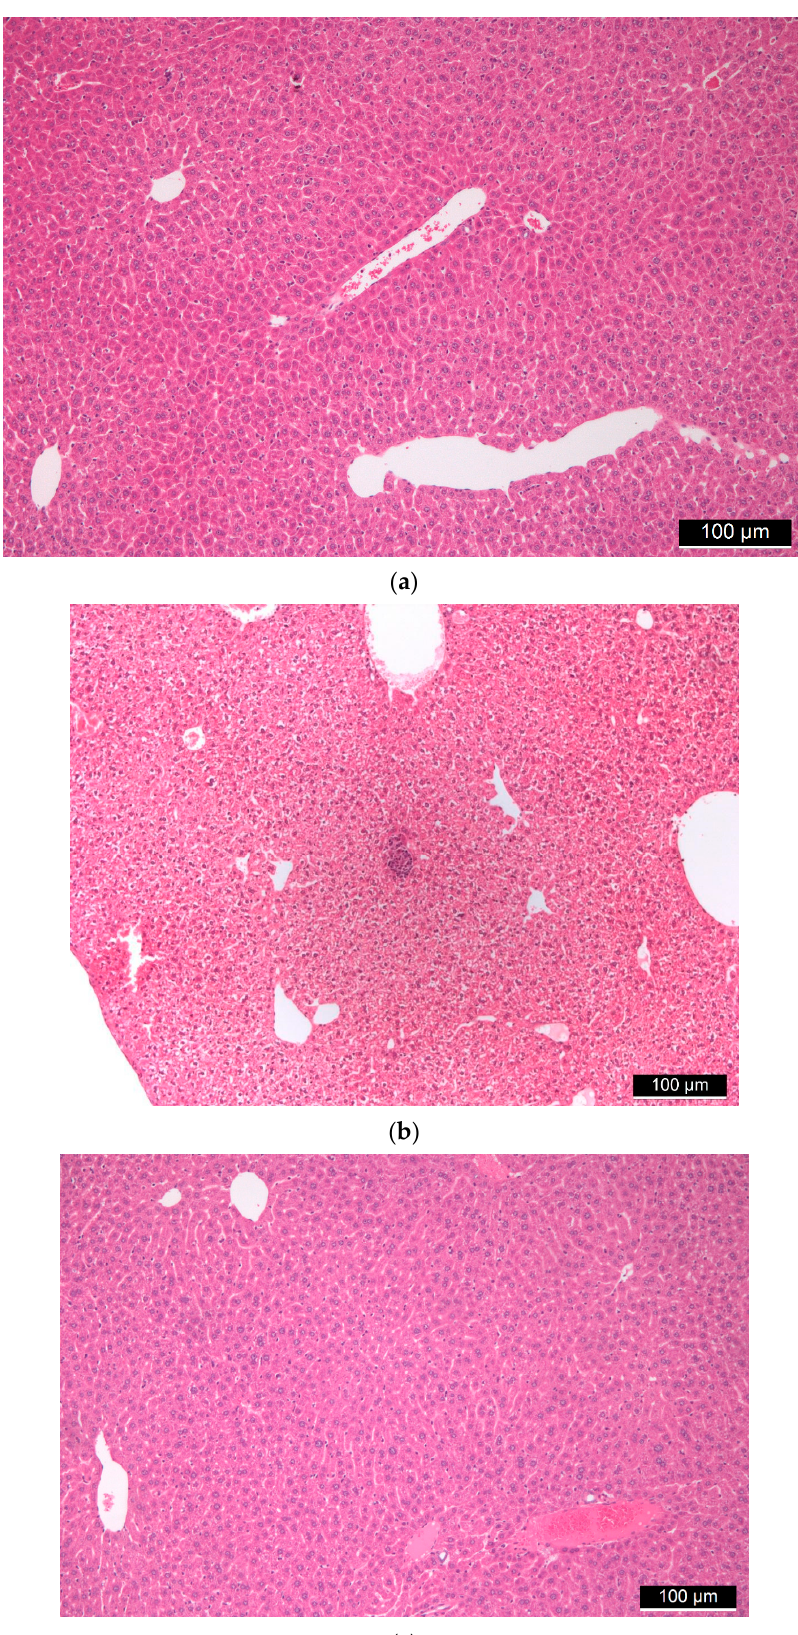
Figure 3. ( a ) Control liver tissue. ( b,c ) Liver tissues of “low dose” ( b ) and “high dose” ( c ) FSGM-treated mice.